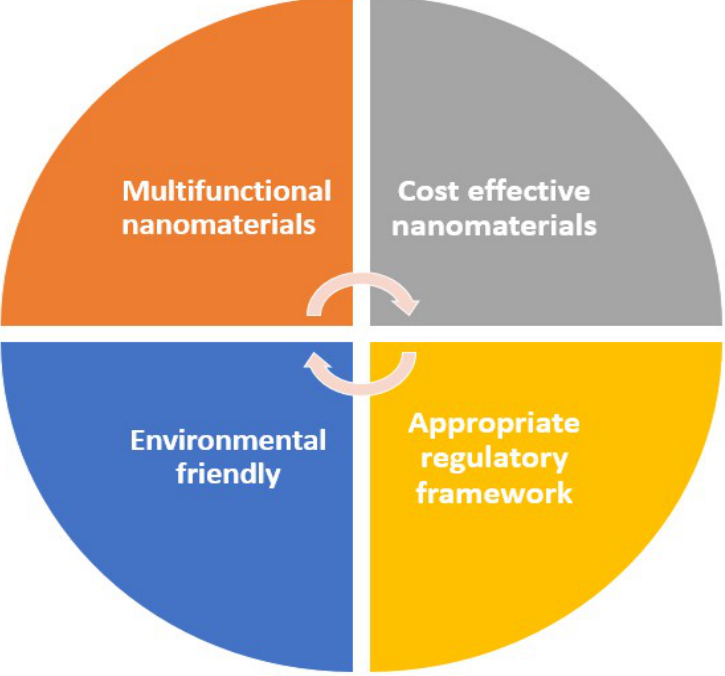
Figure 17. Major four research gaps and future opportunities which need to be considered for the broad and sustainable application of nanotechnology in transportation